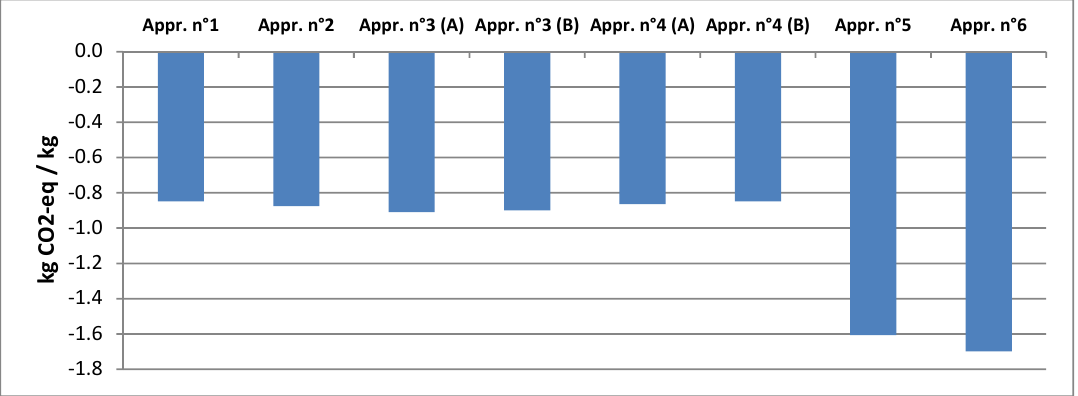
Figure 7. Potentially avoided greenhouse gas production of each approach.